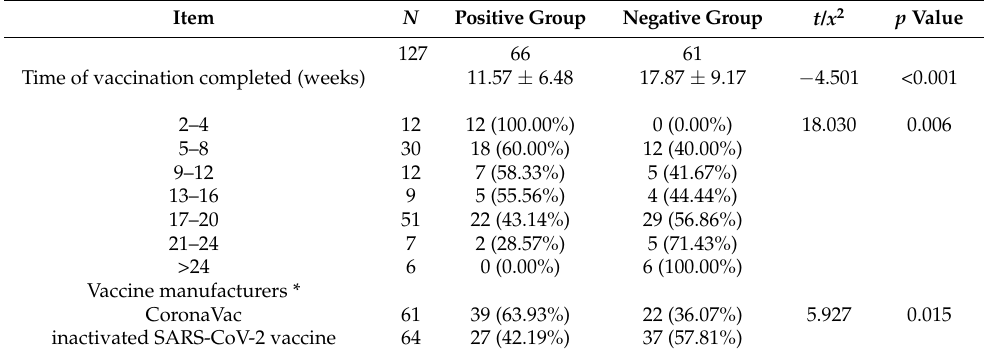
Table 3. Results of SARS-CoV-2 neutralizing antibodies in 127 cases by vaccination